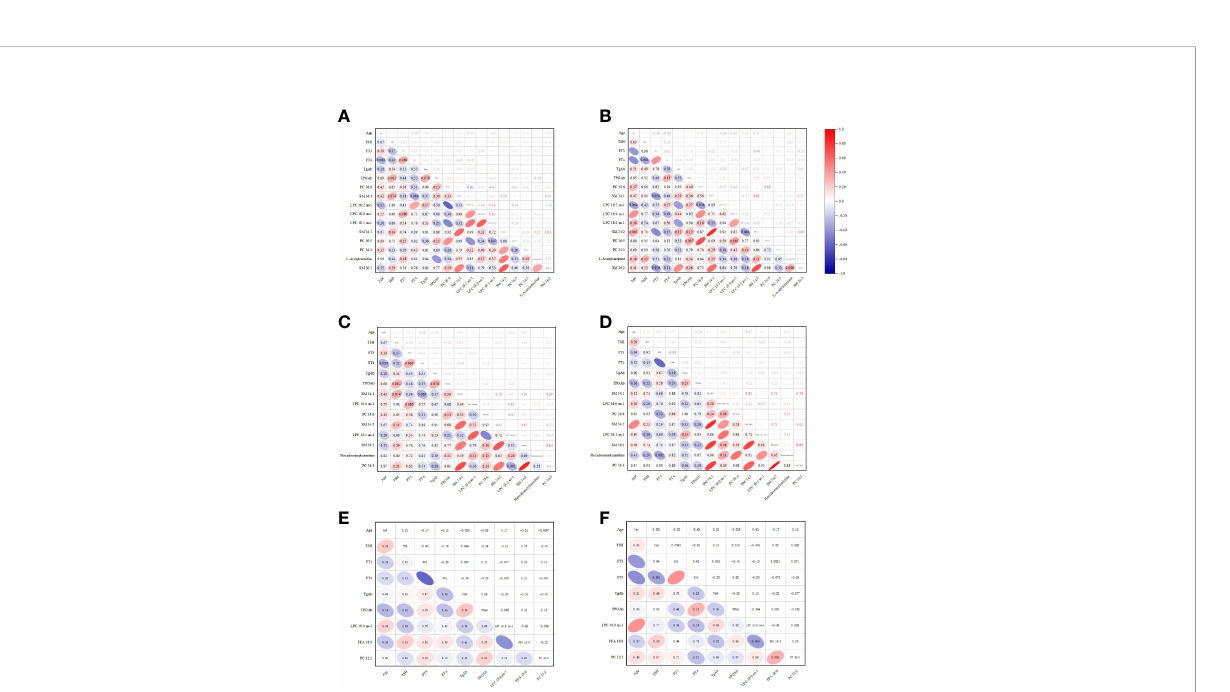
FIGURE 4 The Pearson correlation coef fi cients between the clinical variables and the metabolites were displayed by Correlograms. (A) The analysis between the clinical variables of control and the metabolites of control vs HTE. (B) The analysis between the clinical variables of HTE and the metabolites of control vs HTE. (C) The analysis between the clinical variables of control and the metabolites of control vs HTS. (D) The analysis between the clinical variables of HTS and the metabolites of control vs HTS. (E) The analysis between the clinical variables of HTE and the metabolites of HTE vs HTS. (F) The analysis between the clinical variables of HTS and the metabolites of HTE vs